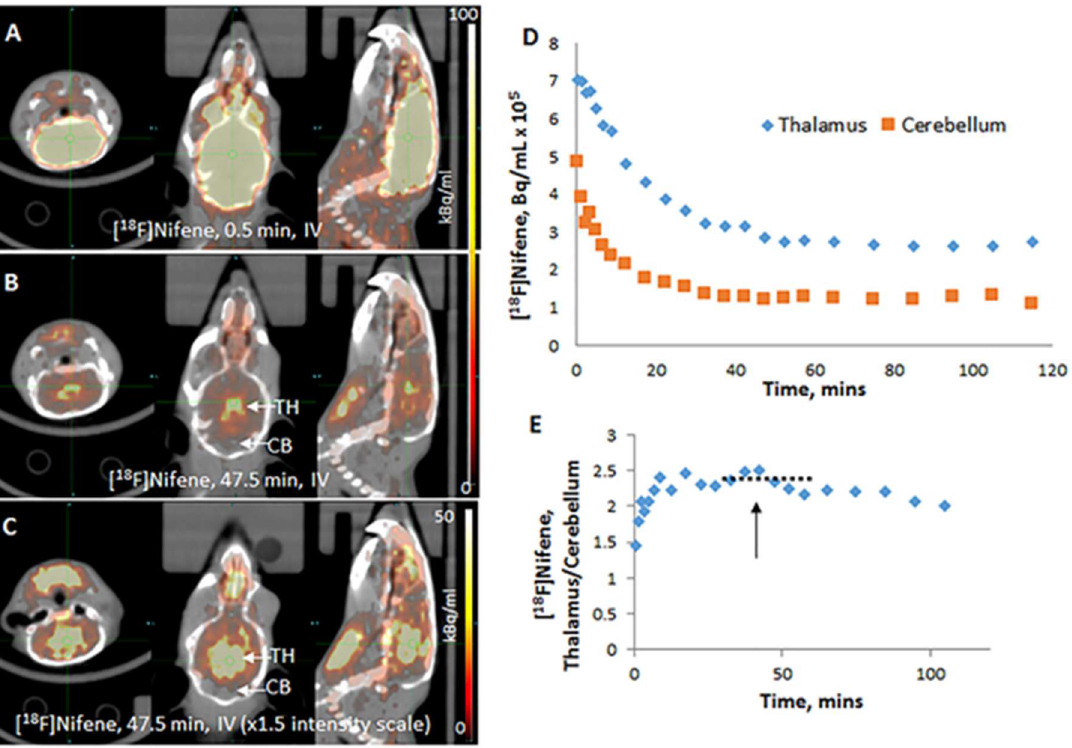
Figure 3. PET/CT of intravenous (IV) [ 18 F]nifene (5.55 MBq in 20 mL saline) administered in wild-type mouse (BALB/c, female 24 g). ( A ) Coronal, transaxial, and sagittal images of mouse head at 0.5 min after injection showing high levels of [ 18 F]nifene in the brain; ( B ) coronal, transaxial, and sagittal images of same mouse head at 47.5 min after injection; ( C ) PET intensity increased (×1.5) of images in ( B ) showing [ 18 F]nifene bound the thalamus and cortical regions; ( D ) time–activity curve of thalamus and cerebellum of region-of-interest shown on the sagittal slices; ( E ) ratio of thalamus to cerebellum of time–activity curve showing plateau between 30 to 60 min (dotted line).